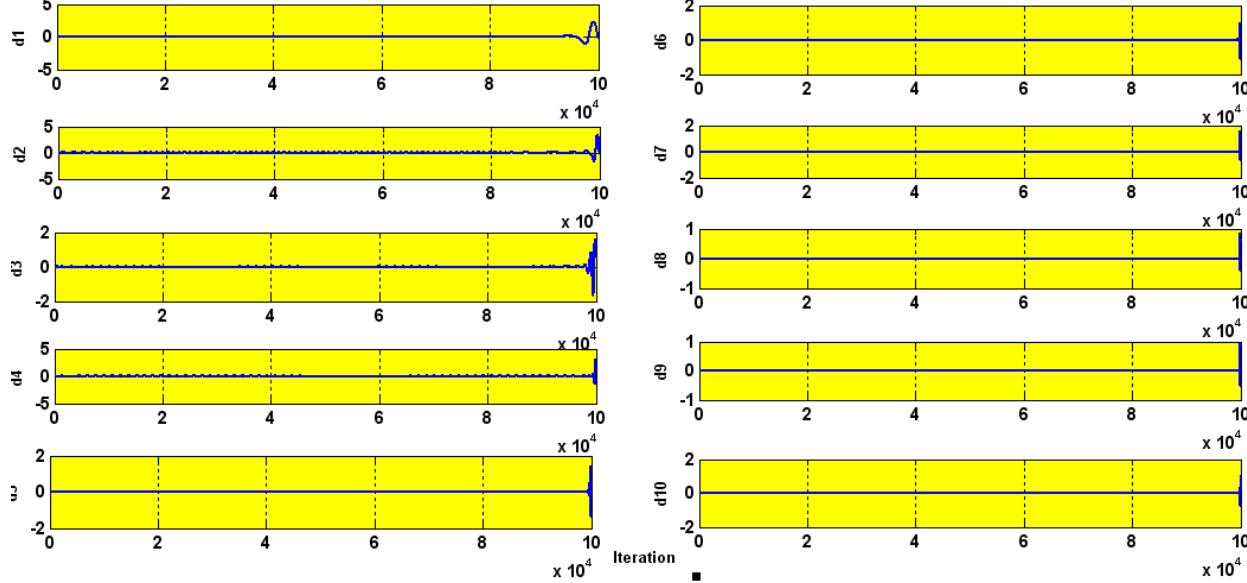
Figure 15. Wavelet decomposition in healthy